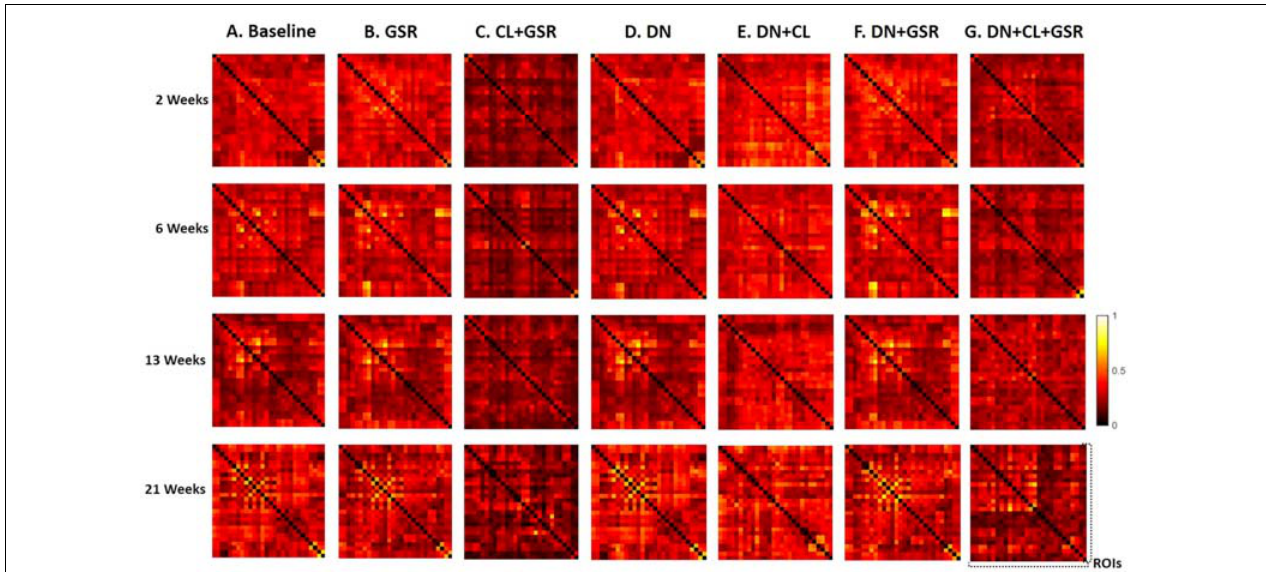
FIGURE 6 | Standard deviation of the Fisher z -transformed correlation coefficient for functional connectivity in the CTL group of Cohort 1 at four different timepoints for the seven pipelines (A–G) . Pipelines including CL and GSR (C,G) obtained the minimal within-group variability in the homogeneous group of healthy controls for all timepoints, whereas other procedures excluding CL and/or GSR had higher variability.